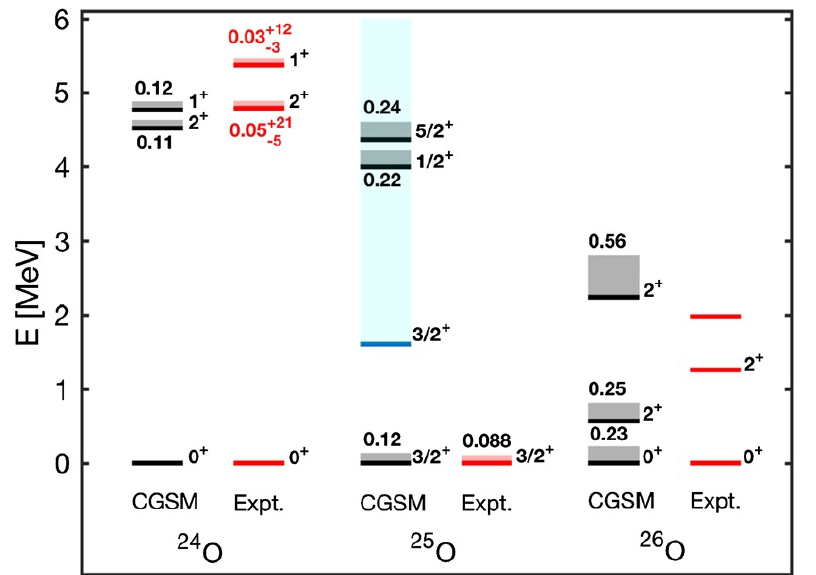
Figure 2. Calculated spectrum of 24,25,26 O, compared with available experimental data [8,10,74]. The resonances are indicated by shades, and their widths (in MeV) are given by the number below or above the levels. The light blue shade indicates the 3/2 + many-body scattering states (with permissions from Ref. [38]). The “CGSM” stays for “core Gamow shell